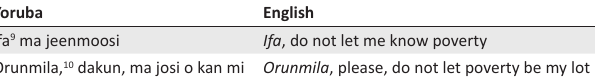
TABLE 2: Potent words to get rich in Yoruba.